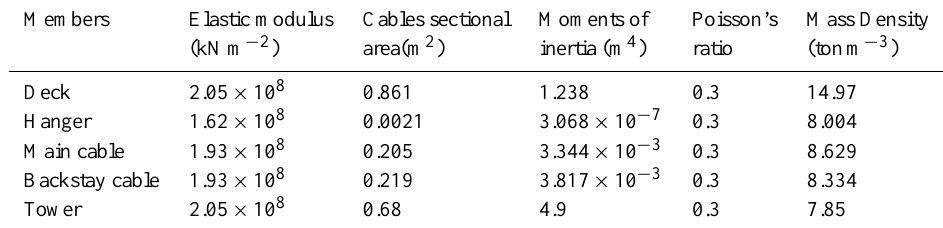
Table 1. Properties of selected near-fault ground motion record (the component YPT-UP) and far-fault ground motion record (the component GBZ-UP) in Kocaeli Earthquake ( M = 7 . 4), 17 August 1999. Ground motion Component Station Distance PGA PGV PGD PGV/PGA to fault (km) (g) (cm/sn) (cm) (s) Near-Fault YPT-UP Yarimca Far-fault